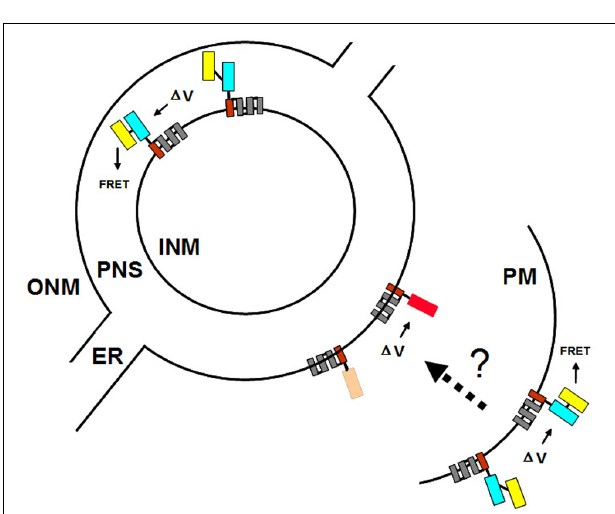
FIGURE 5 | Expression ofVSFP3.1TagRFP from the Ubi-10 promoter and targeting to nuclear membrane in root cells. Images show expression of the intensity-basedVSFP3.1TagRFP from the Ubi-10 promoter at the plasma membrane (A) and the nuclear membrane ( B , + WPP) in cells of the root maturation zone. In (B) , only some background fluorescence is seen in the